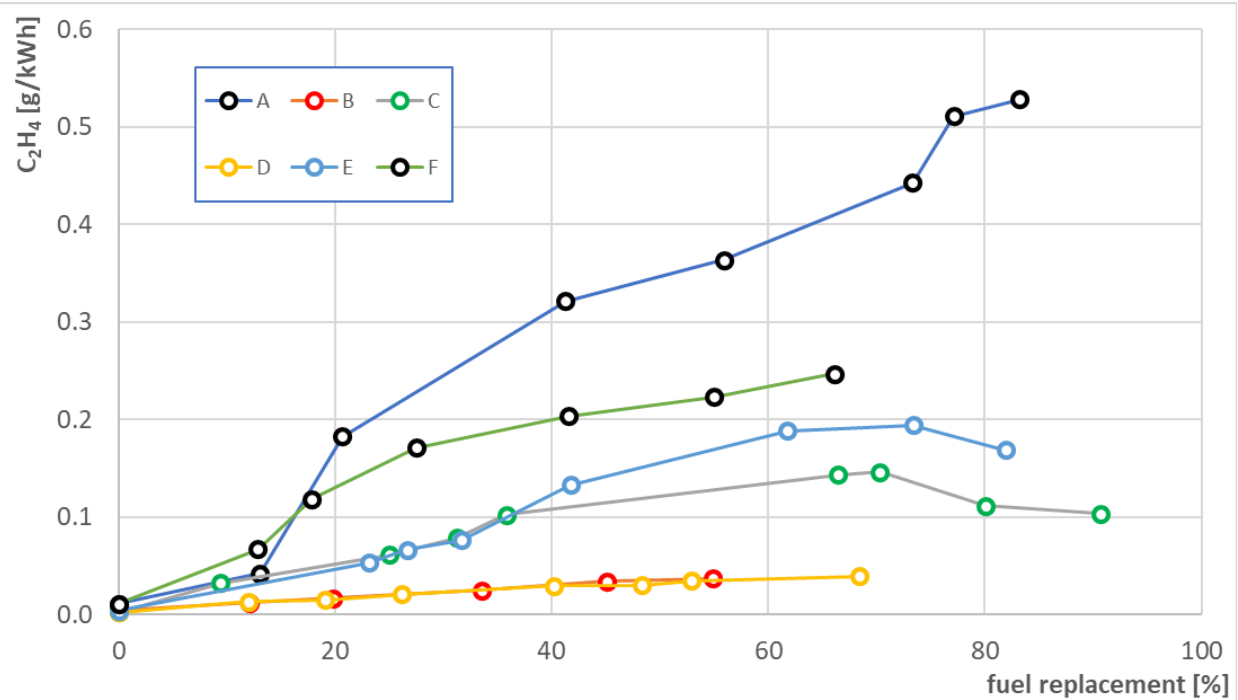
Figure 17. Curves from A to F showing engine’s emission of C 2 H 4 (ethene), for individual engine operating points, where the rotation speed, power, and torque were constant, as a replacement function of diesel fuel replaced by CNG.